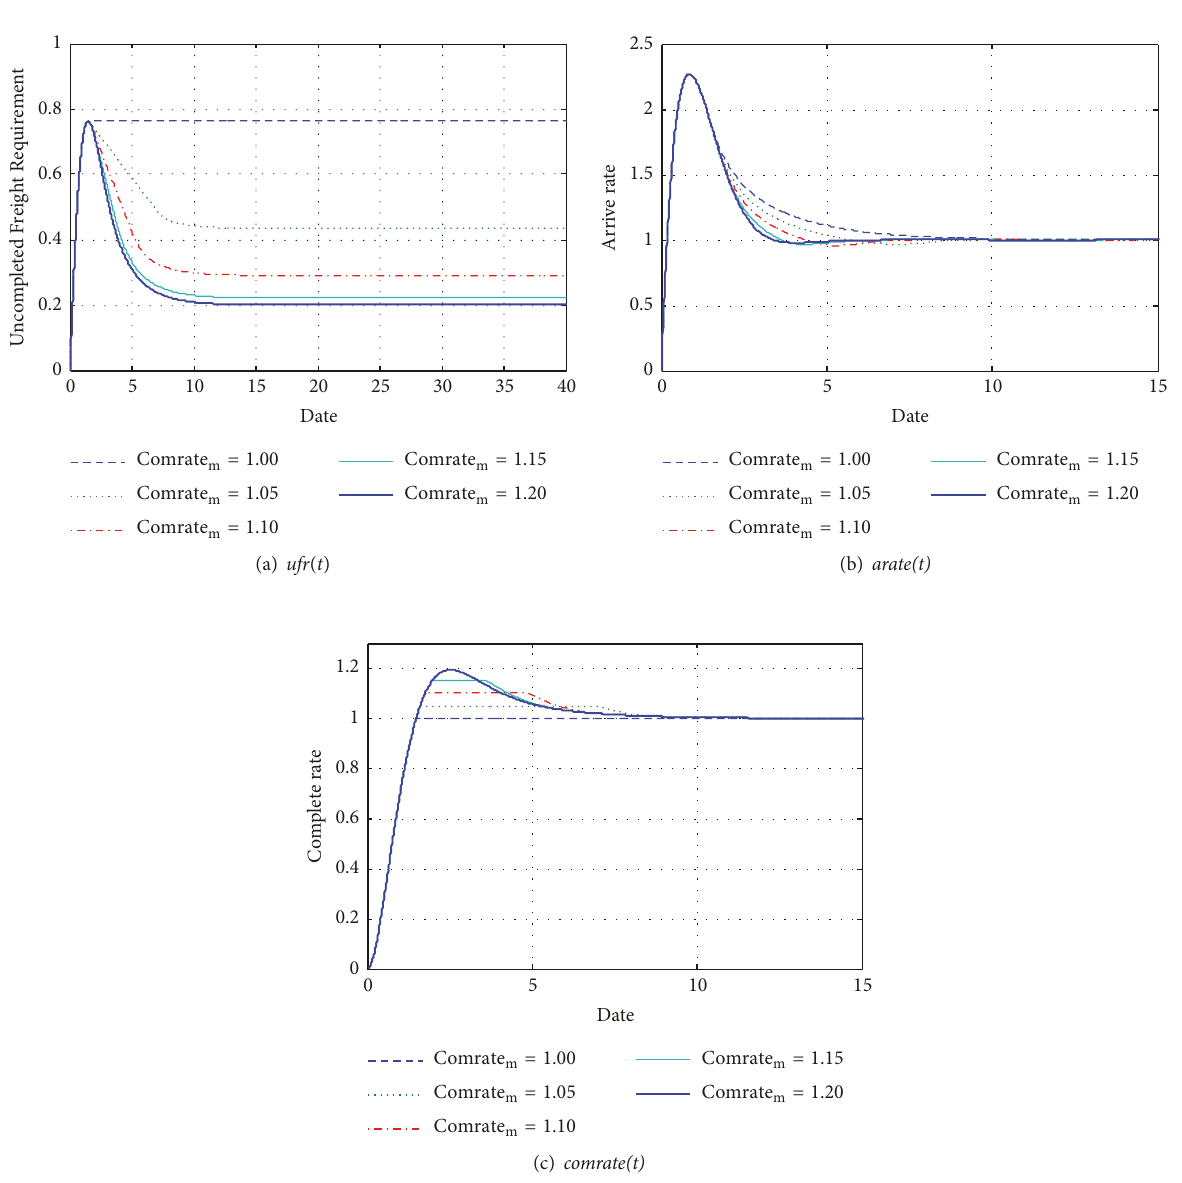
Figure 9: States and outputs in nonlinear HCS with different COMRATE m